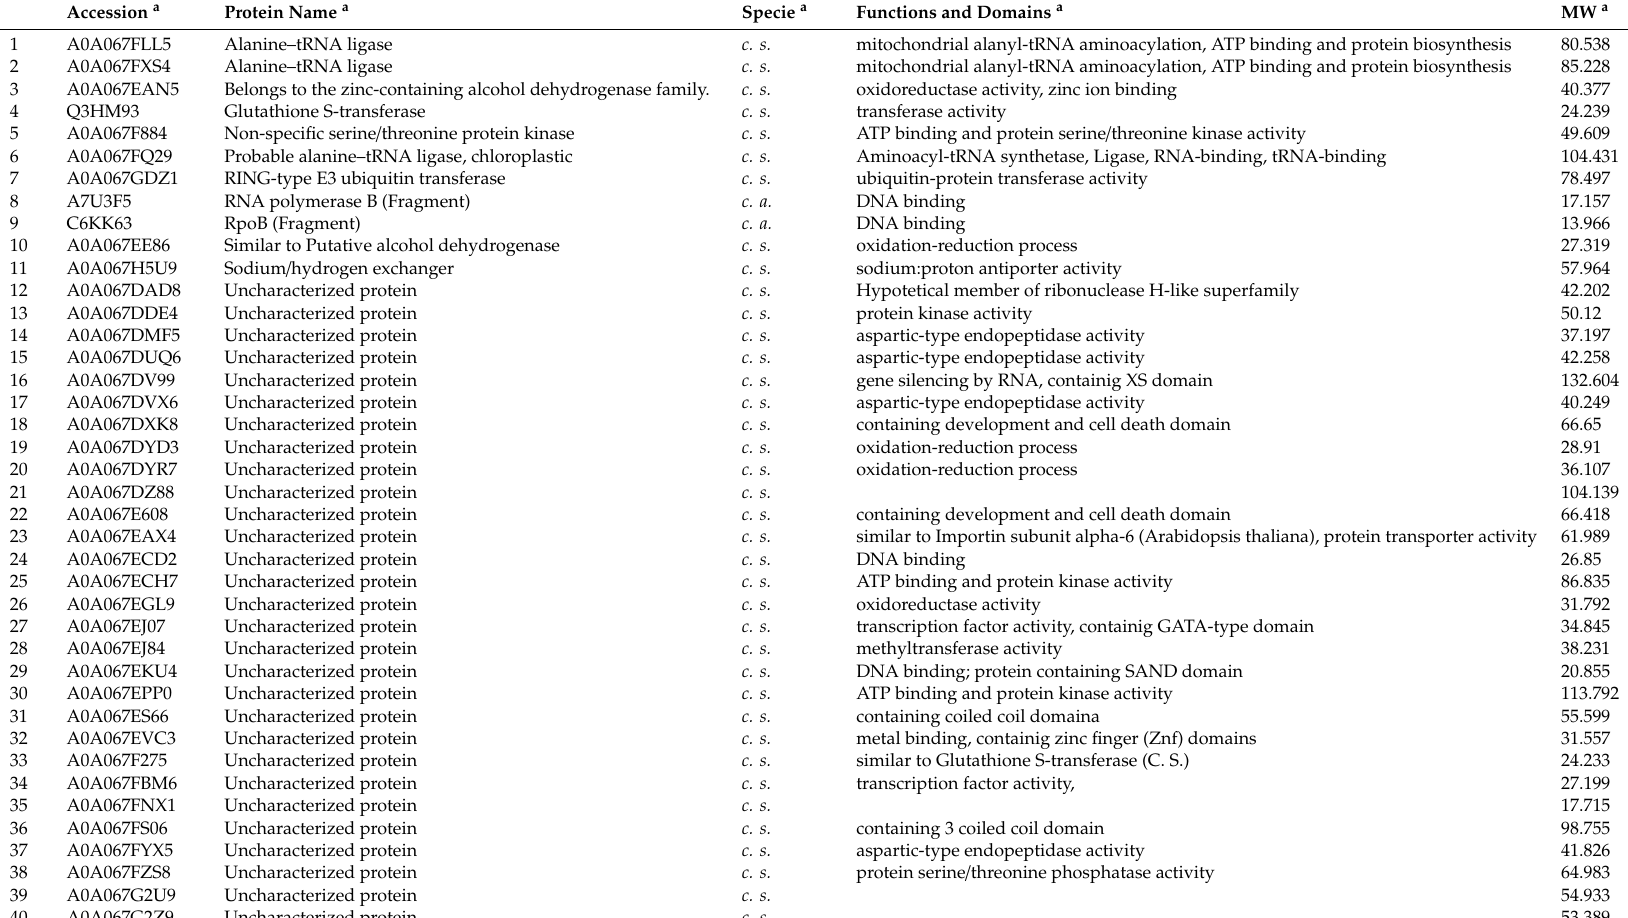
Table 1. Identified proteins by matrix-assisted laser desorption ionization tandem mass spectrometry (MALDI MS / MS) and Protein Pilot Paragon Method. The tandem mass spectrometry (MS / MS) data were processed using a mass tolerance of 10 ppm and 0.2 Da for the precursor and fragment ions,